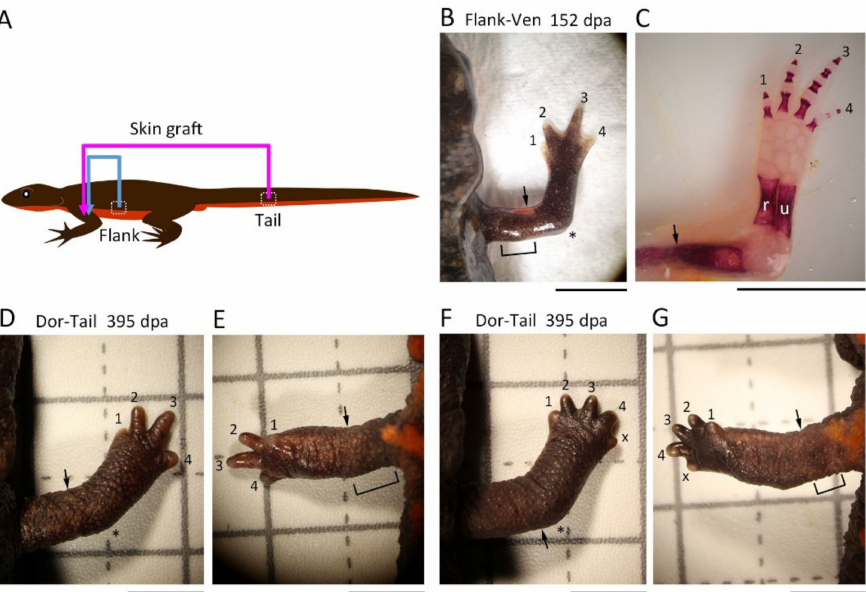
Figure 7. Effects of flank/tail skin grafting on limb regeneration. ( A ) Schematic showing the surgical process. ( B ) Representative showing normal regeneration in the Flank–Ven pattern of skin graft (n = 3). In this operation, a dorsal half skin was replaced with flank skin. ( C ) The skeleton of the limb shown in ( B ). ( D ) Representative showing normal regeneration in the Dor–Tail pattern of skin graft (dorsal view; n = 2). In this operation, a ventral half skin was replaced with tail skin. ( E ) Ventral view of the limb in ( D ). ( F ) A regenerating limb with a 5-digit hand in the Dor–Tail pattern of skin graft (dorsal view; n = 1). ( G ) Ventral view of the limb in ( F ). The number near the digit indicates digit number. X indicates the digit whose number could not be determined. The asterisk indicates the elbow. The arrow indicates the amputation position. dpa: day post amputation; u: ulna; r: radius; h: humerus. Scale bars: 5 mm ( B , D – G ); 1 cm ( C